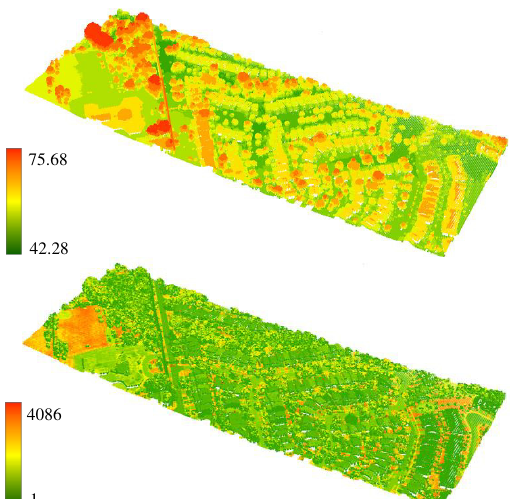
Figure 2. LiDAR point clouds from C2 for Site II (upper: height and lower: intensity) Optech Titan sensor acquired LiDAR data for L1and L3 in the three channels at ~420m altitude, ±15° scan angle, 200 kHz/channel PRF and 40 Hz scan frequency. The tested LiDAR data of Site I contains about 1755530, 2013832, and 2256815 points from C1, C2, and C3, respectively, while Site II contains about 1874916, 2022127, and 2036271 points from C1, C2, and C3, respectively. The difference in number of points depends on the interaction of each feature with different wavelengths (e.g., reflection from water surface and/or seabed, and greenness of the vegetation). A Google® image was used to validate the classification results using number of reference points, obtained from selected polygons for different land covers, Figure 3.